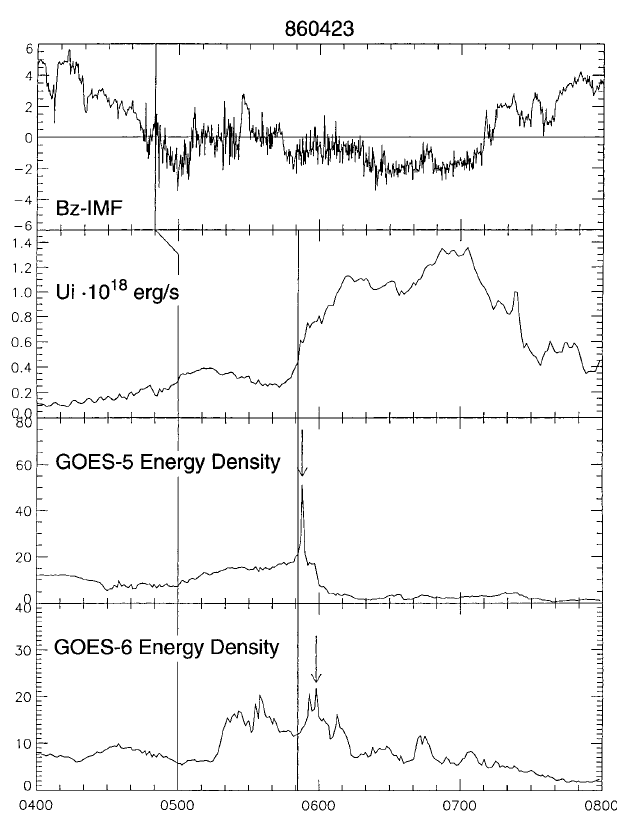
Fig. 5. From top to bottom panels : the interplanetary magnetic field Bz component from IMP8 spacecraft (in 15.5 s resolution), the energy consumption rate in the auroral ionosphere U and the magnetic I energy density from GOES-5 and GOES-6 for the April 23, 1986 event. The southward turning of the IMF at 0450 UT caused the start of the substorm at 0500 UT on the ground. The directly driven and the loading mechanism as well are in progress until 0551 UT, where the onset at AL index is detected (indicated by the second vertical line ). The unloading of the stored energy occurred at 0553 UT from GOES- 5 and at 0607 UT